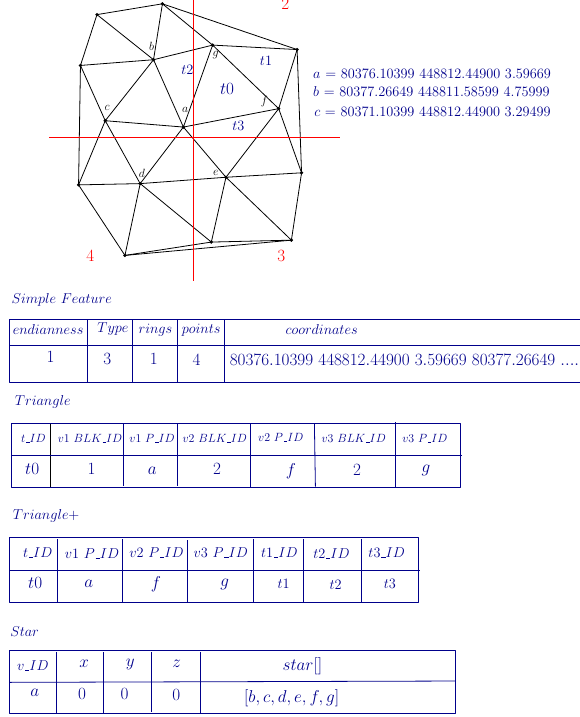
Figure 17: Row structure in SF, Triangle, Triangle+ and